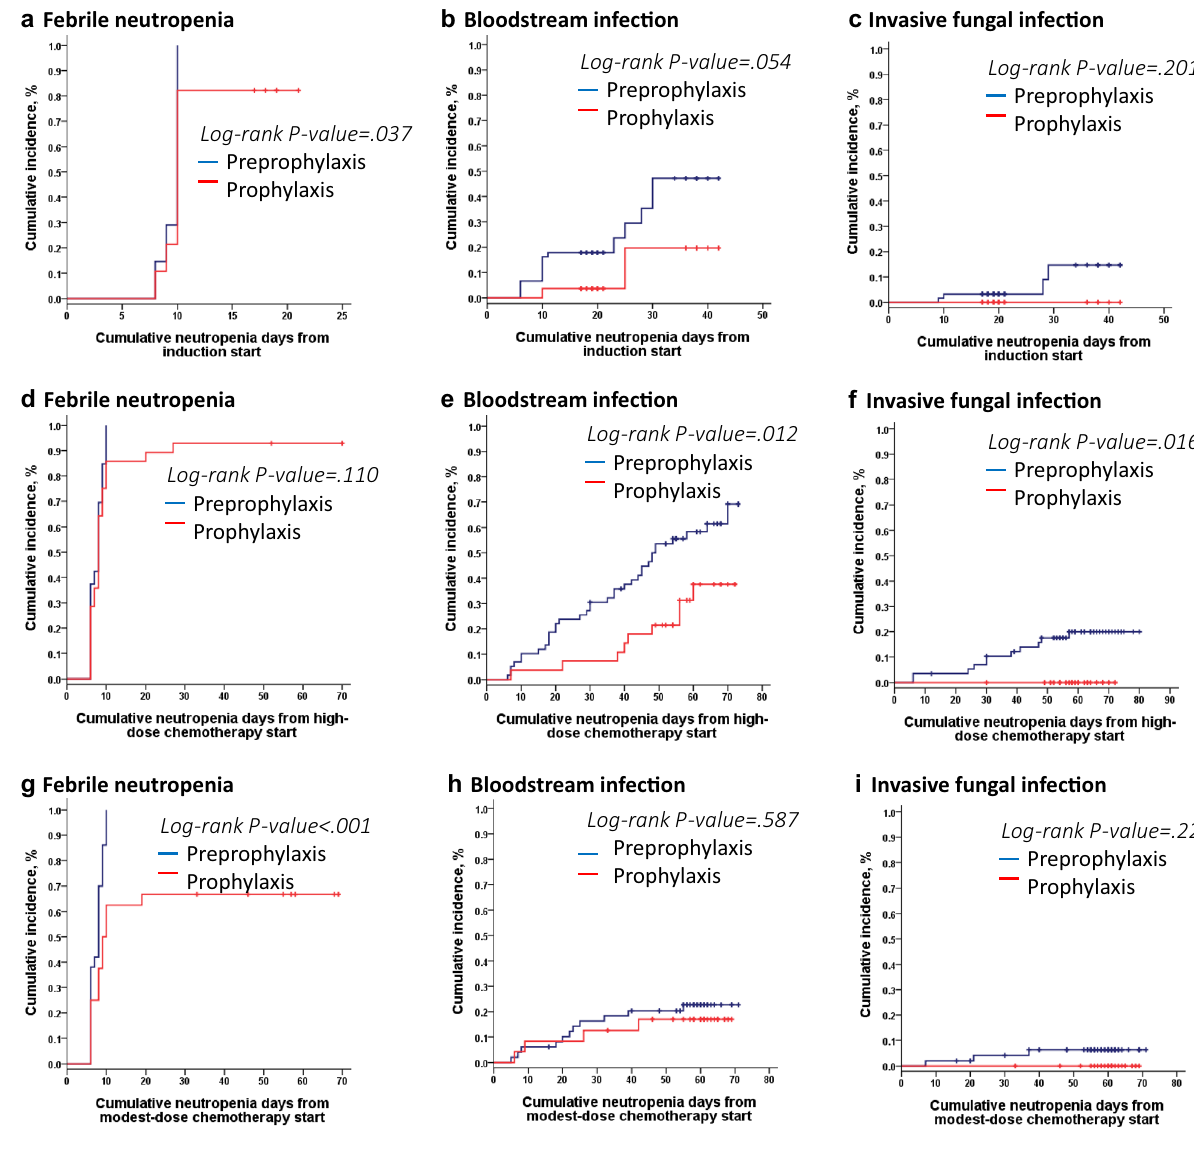
Figure 1. Cumulative incidence of febrile neutropenia, bloodstream infection, invasive fungal infection during induction, high-dose, and modest-dose chemotherapy between the preprophylaxis and prophylaxis period are